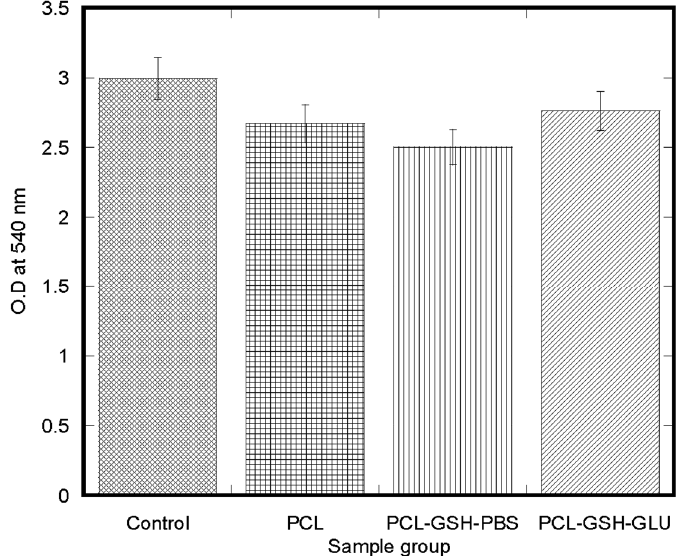
Figure 8. Analyses of MTT metabolic activity by fibroblasts cultured in tested conditions (n = 4). No statistical significant differences were found between any group in the figure.